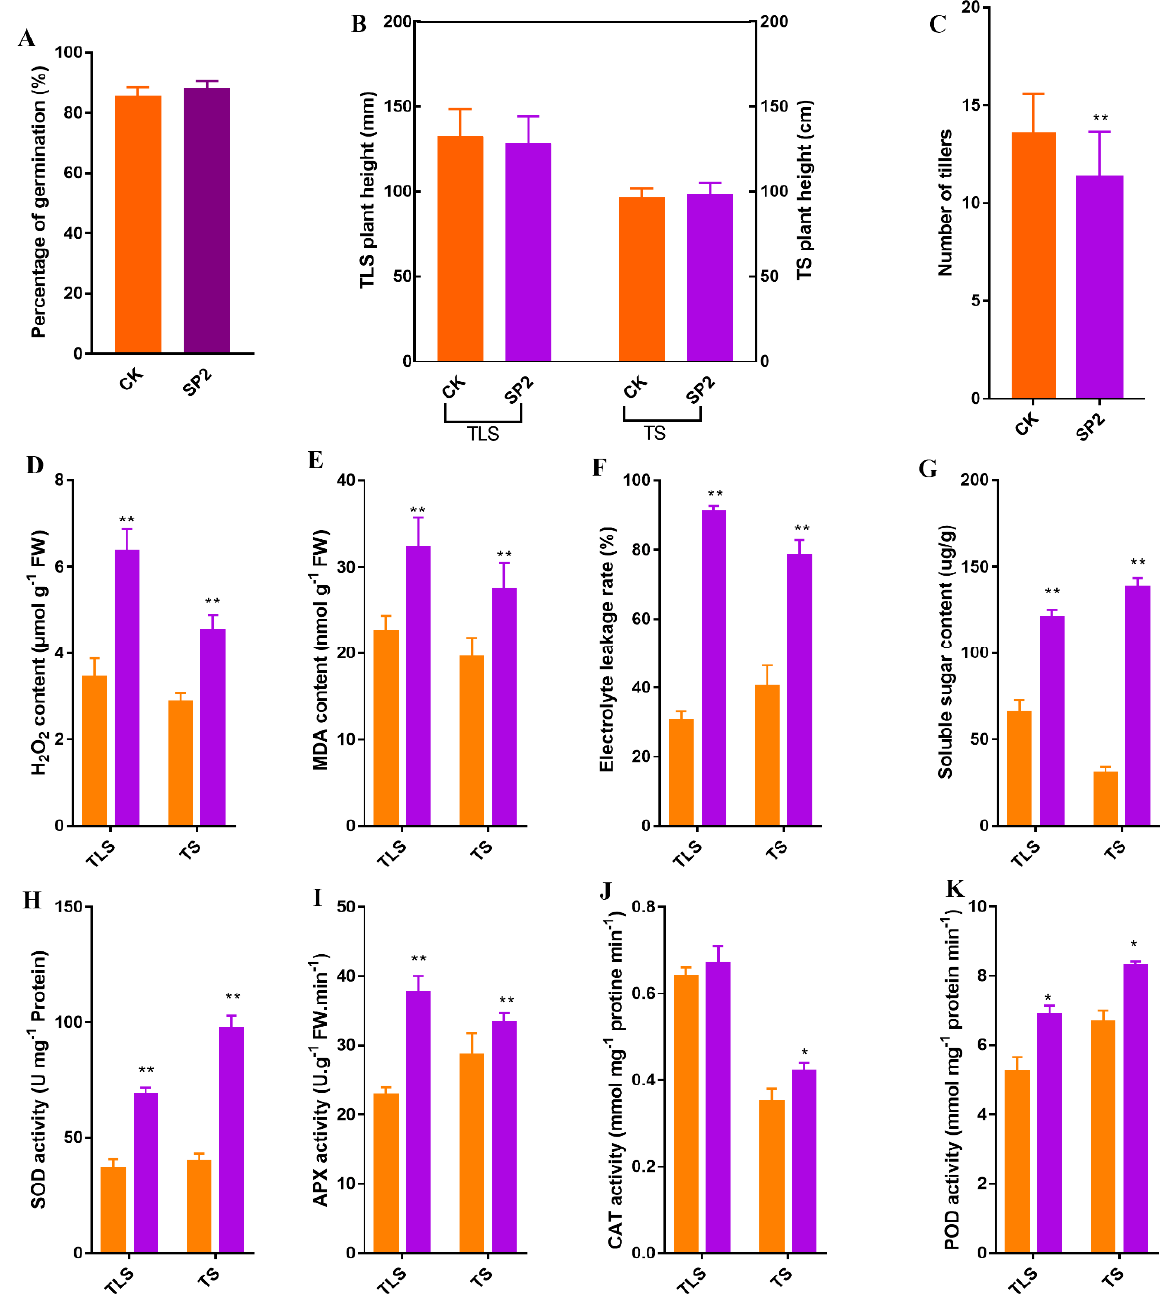
Figure 1. The morphology and physiology of offspring rice induced by spaceflight. ( A ) Percentage of germination. ( B ) Plant height. ( C ) Number of tillers. TLS, three ‐ leaf stage; TS, tillering stage; the orange column represents the control group; the purple column represents the spaceflight group. ( D ) H 2 O 2 con ‐ tent. ( E ) MDA content. ( F ) The electrolyte leakage rate. ( G ) The soluble sugar contents. ( H ) SOD activity. ( I ) APX activity. ( J ) CAT activity. ( K ) POD activity. Data are expressed as mean ± SD, n = 30 ( A – C ). The data (mean ± SD) are the means of three replicates with standard errors shown by vertical bars, n = 3 ( D – K ), * and ** indicate significant difference at p < 0.05 and <0.01 by Tukey’s test, respectively.